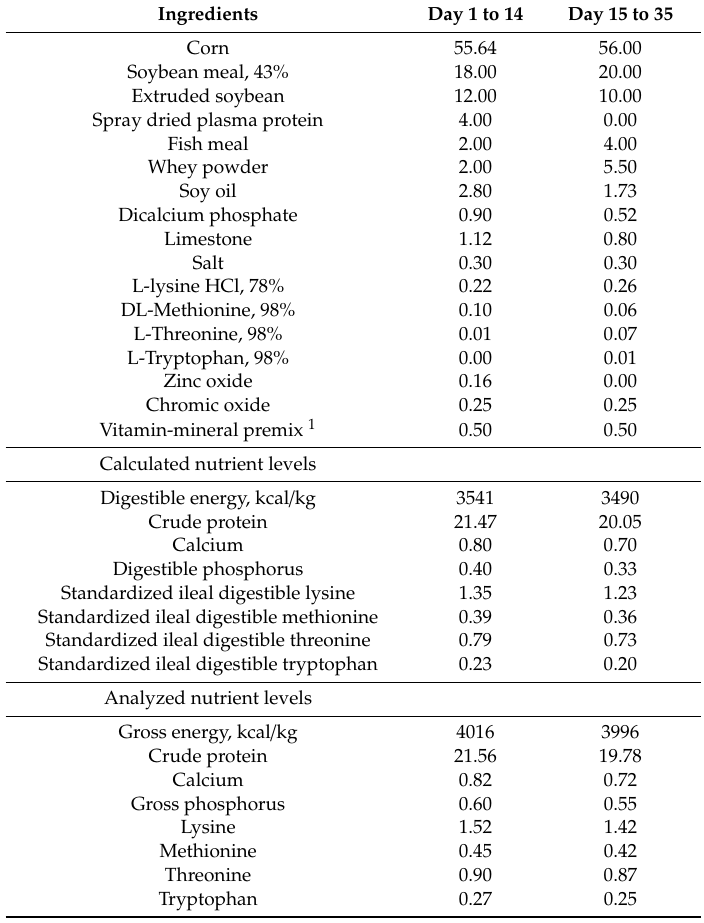
Table 1. Composition and nutrient levels of basal diets (%, as-fed basis).